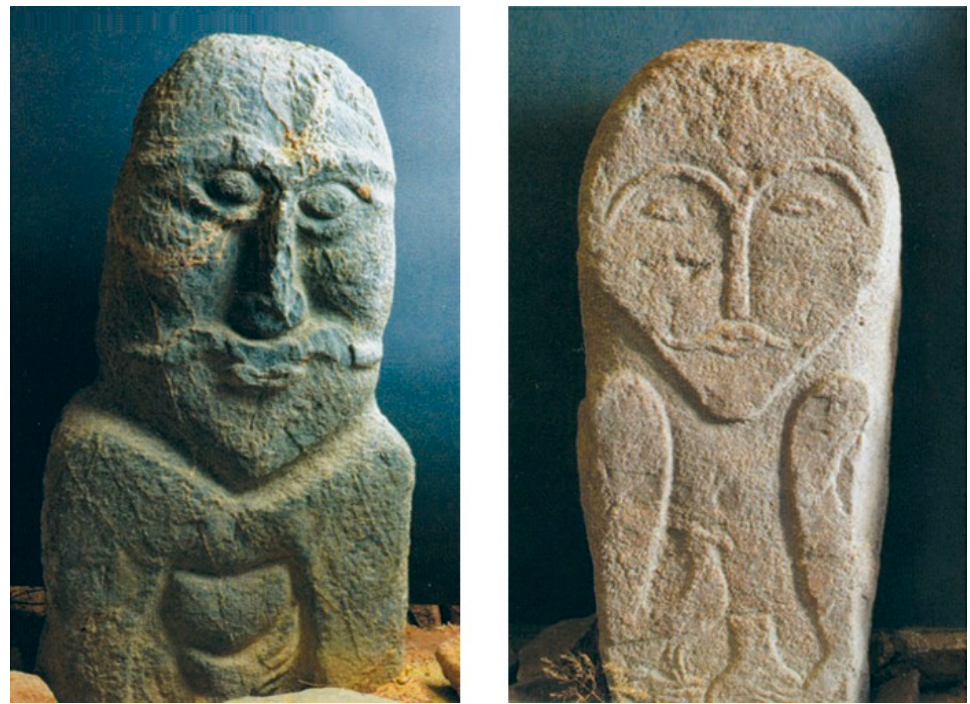
Figure 6. Archaic women made of stone. Kamennye Baby .